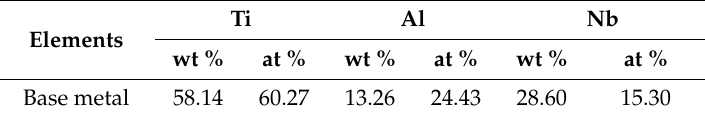
Table 1. Chemical compositions of the Ti-24Al-15Nb alloy base metal.